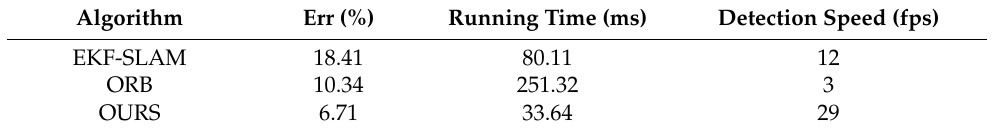
Figure 7. Real-time reconstruction results of monocular cameras in complex scenes. ( a ) RGB image; ( b ) Depth image; ( c ) Object extraction results obtained by YOLACT++; and ( d – f ) Real-time 3D reconstruction results from different views. Table 5. The performance of our method and other main methods on the YCB-Video